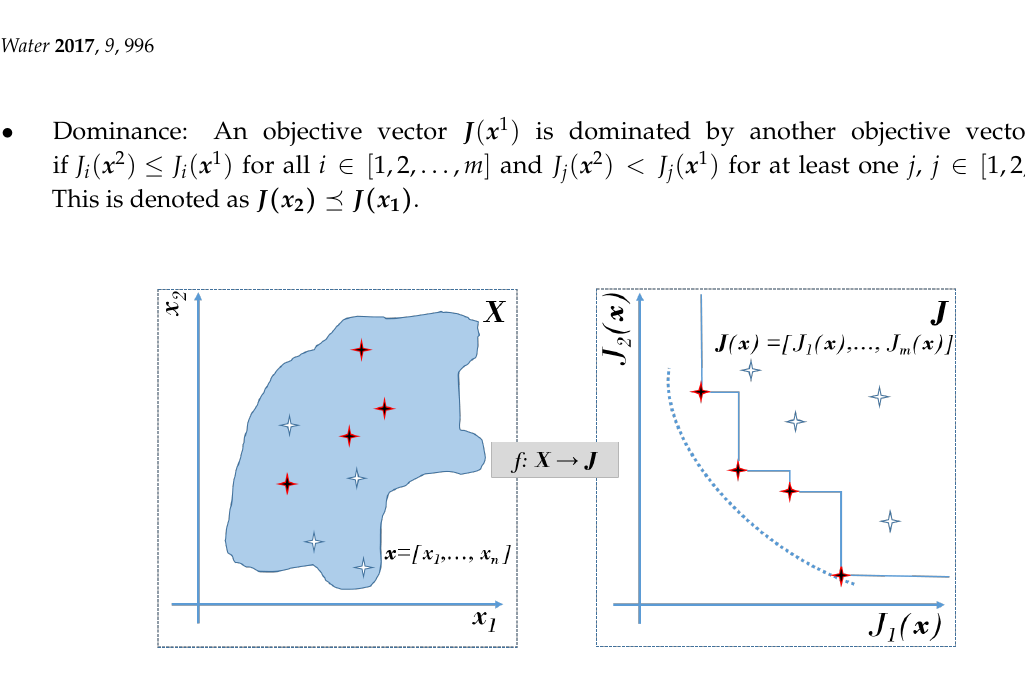
Figure A1. Pareto optimality and dominance concepts for a min-min problem. Dark solutions is the subset of non-dominated solutions which approximates a Pareto front ( right ) and a Pareto set ( left ). Remainder solutios are dominated solutions, because it is possible to find at least one solution with better values in all design objectives (Source: